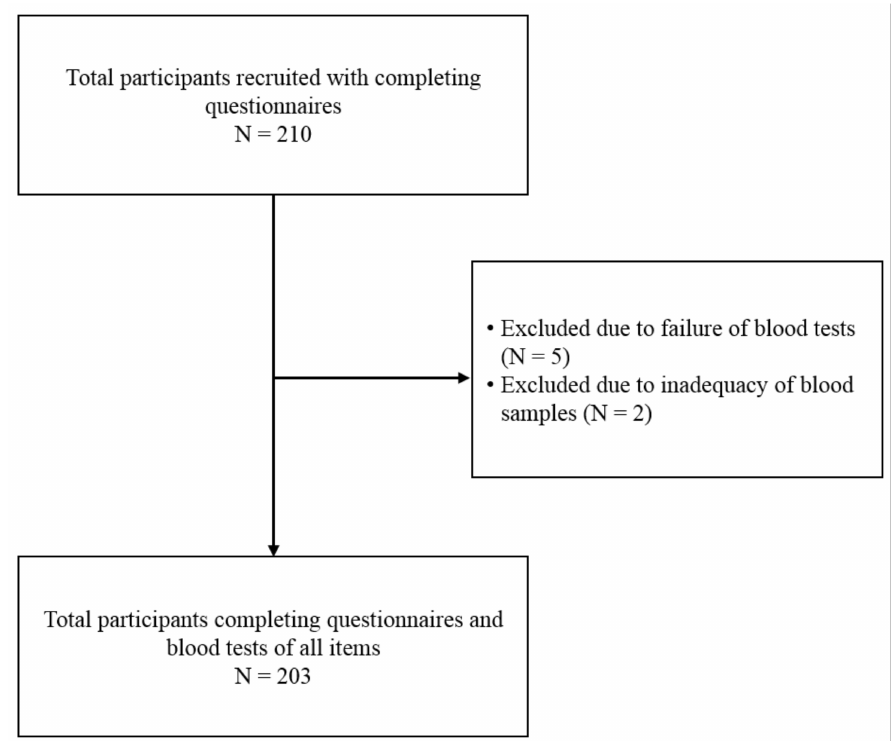
Figure 1. Flow chart of patient selection for the